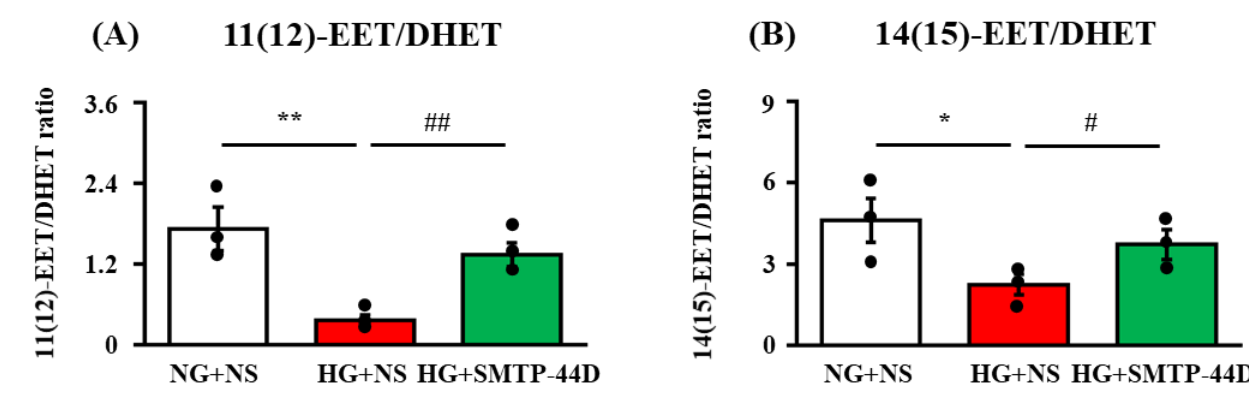
Figure 1. The ratio of 11(12)-EET/DHET ( A ) and 14(15)-EET/DHET ( B ) in response to SMTP-44D in IMS32 cells under high glucose conditions. IMS32 cells were incubated with SMTP-44D (30 µ M) from 48 to 96 h after the HG treatment. The levels of EETs and DHETs were determined 96 h after the HG treatment. The data are expressed as the mean ± S. E. M. ( n = 3). * p < 0.05, ** p < 0.01 vs. NG + NS group; # p < 0.05, ## p < 0.01 vs. HG + NS group by one-way analysis of variance